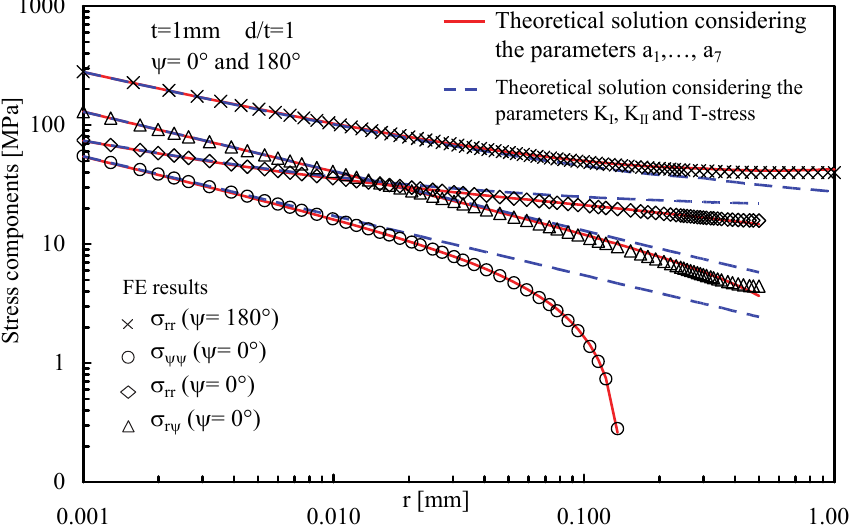
Figure 2: Stress field along the ligament line for the case d/t=1 and t=1 mm.